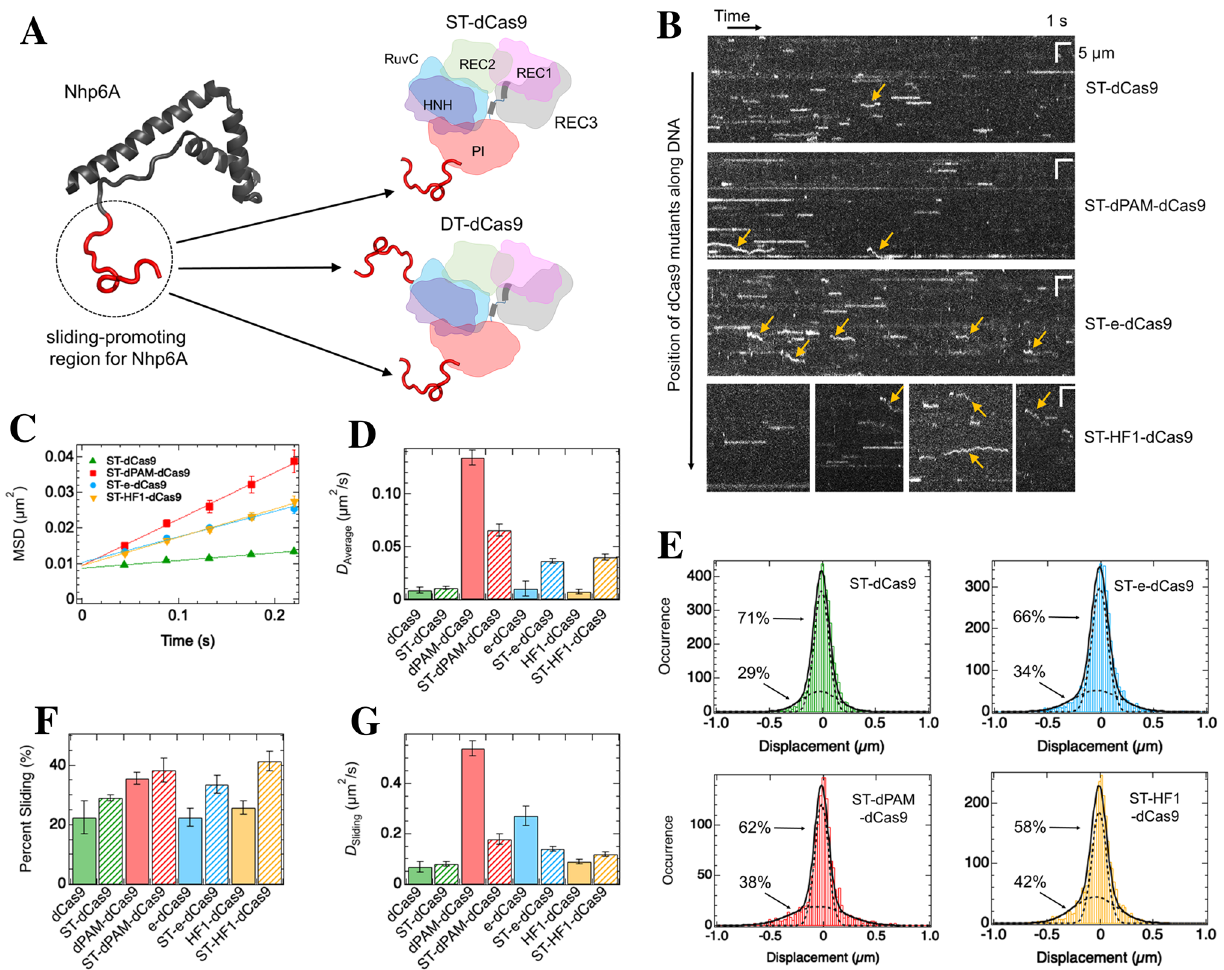
Figure 3. The basic tail of Nhp6A enhances the sliding mode population of dCas9 in the absence of sgRNA. (A) Schematic diagram of Cas9 hybrids (ST-dCas9 and DT-dCas9) with the sliding-promoting region (red) introduced from Nhp6A (PDB code 1LWM). dCas9 is composed of REC1, REC2, REC3, RuvC, HNH, and PI domains. (B) Typical kymographs of dCas9 hybrid mutants. White lines or curves denote the traces of single molecules. Yellow arrows show sliding molecules. (C) MSD plots of all tracked molecules of dCas9 hybrid mutants ( N = 787 for ST-dCas9, 360 for ST-dPAM-dCas9, 852 for ST-e-dCas9, and 520 for ST-HF1-dCas9). The errors denote standard errors. The best-fit linear lines are shown ( R 2 = 0.88 for ST-dCas9, 0.81 for ST-dPAM- dCas9, 0.87 for ST-e-dCas9, and 0.82 for ST-HF1-dCas9). (D) Average diffusion coefficient of dCas9 hybrid mutants along DNA. (E) Displacement distribution of dCas9 hybrid mutants at a time interval of 176 ms. Black curves are the best-fit curves based on the sum of two Gaussian functions. The dashed curves represent the distributions of each mode. (F) Sliding mode percentage of dCas9 hybrid mutants. (G) Diffusion coefficient of the sliding mode for dCas9 hybrid mutants. In panels D, F, and G, the errors denote fitting errors, and the data of dCas9 and its mutants are displayed for